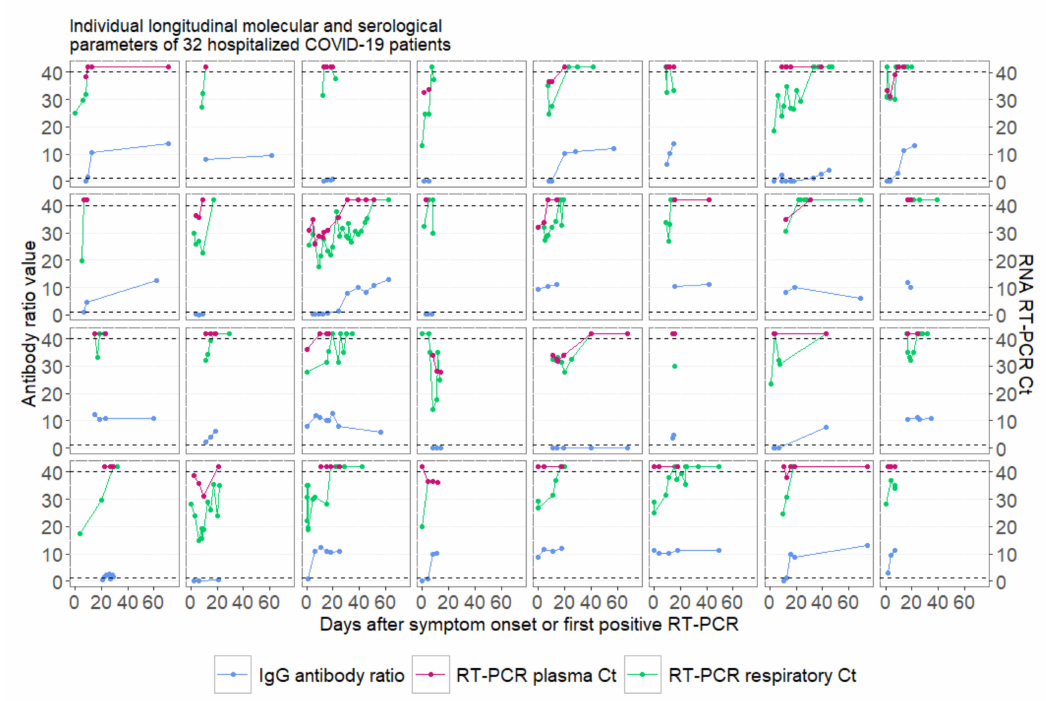
Figure 1. Individual longitudinal development of virologic and serological results of 32 patients with coronavirus disease 2019 (COVID-19) infection during hospital admission. Negative PCR results are displayed above the detection Ct (Cycle threshold) of 40. Dashed horizontal lines display the detection threshold of severe acute respiratory syndrome coronavirus 2 (SARS-CoV-2) RNA Ct values and the antibody cut-o ff of seroconversion for the assay used. RT-PCR, real-time PCR. Although peak viral loads in respiratory samples were higher compared to those in plasma samples, represented by lower SARS-CoV-2 Ct values (Figure 2A,B), nadir Ct values in